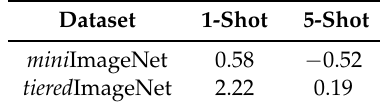
Table 5. Performance gain (in % points) of Looking-Back when trained with higher shots compared to training with same shots.